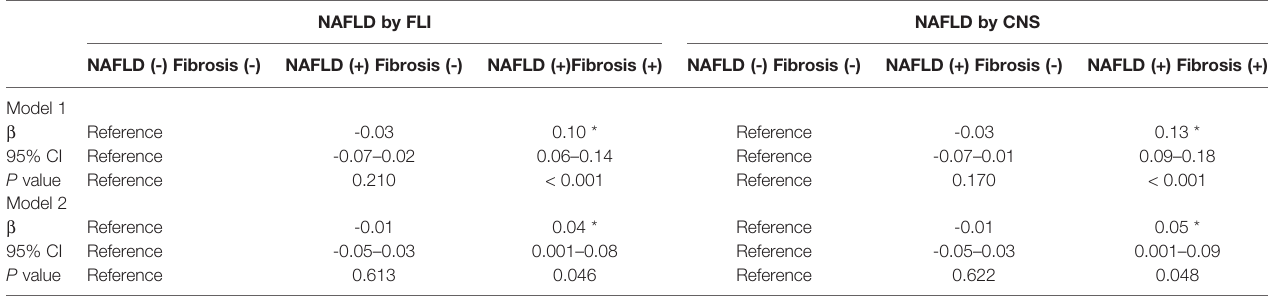
TABLE 3 | Association of NAFLD with FIB-4 – de fi ned liver fi brosis and 10-year hip fracture probability in Korean men aged ≥ 50 years. NAFLD by FLI NAFLD (-) Fibrosis (-) NAFLD (+) Fibrosis (-) NAFLD (+)Fibrosis (+) NAFLD (-) Fibrosis (-) NAFLD (+) Fibrosis (-) NAFLD (+) Fibrosis